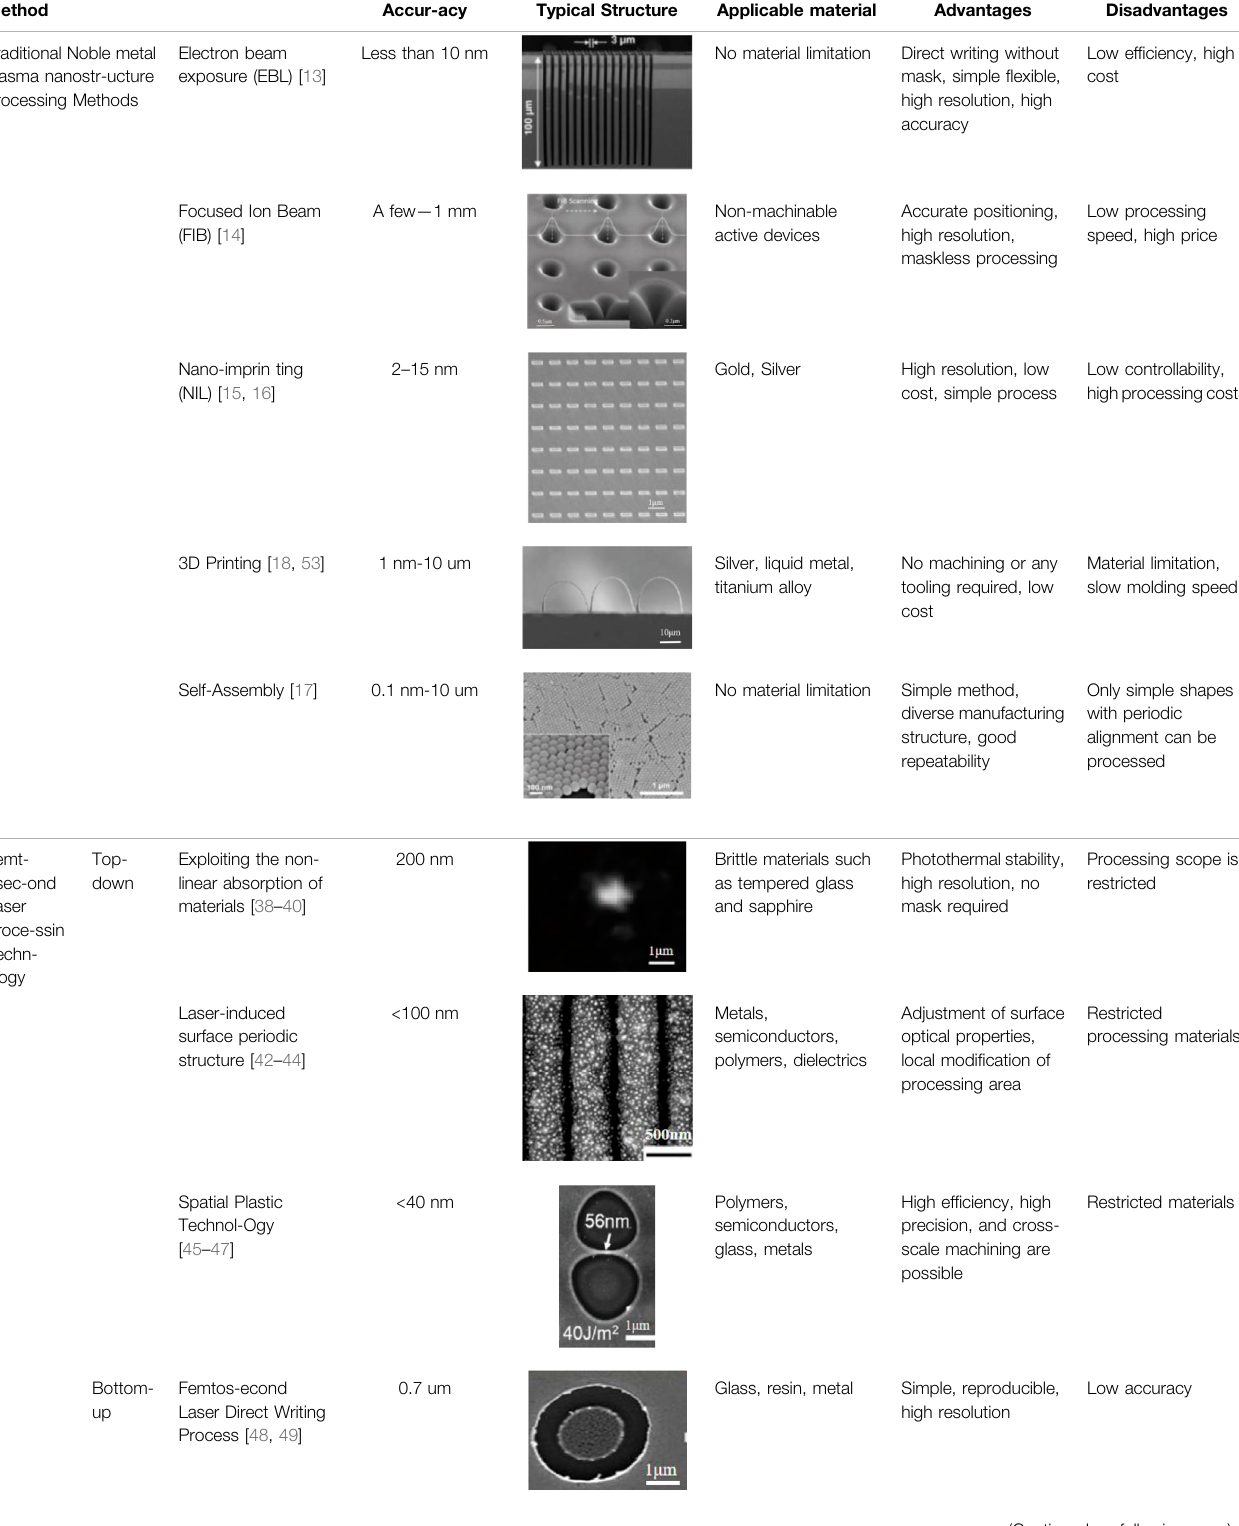
TABLE 1 | Summary of preparation methods for plasma nanostructures of precious metals, including processing accuracy, advantages and